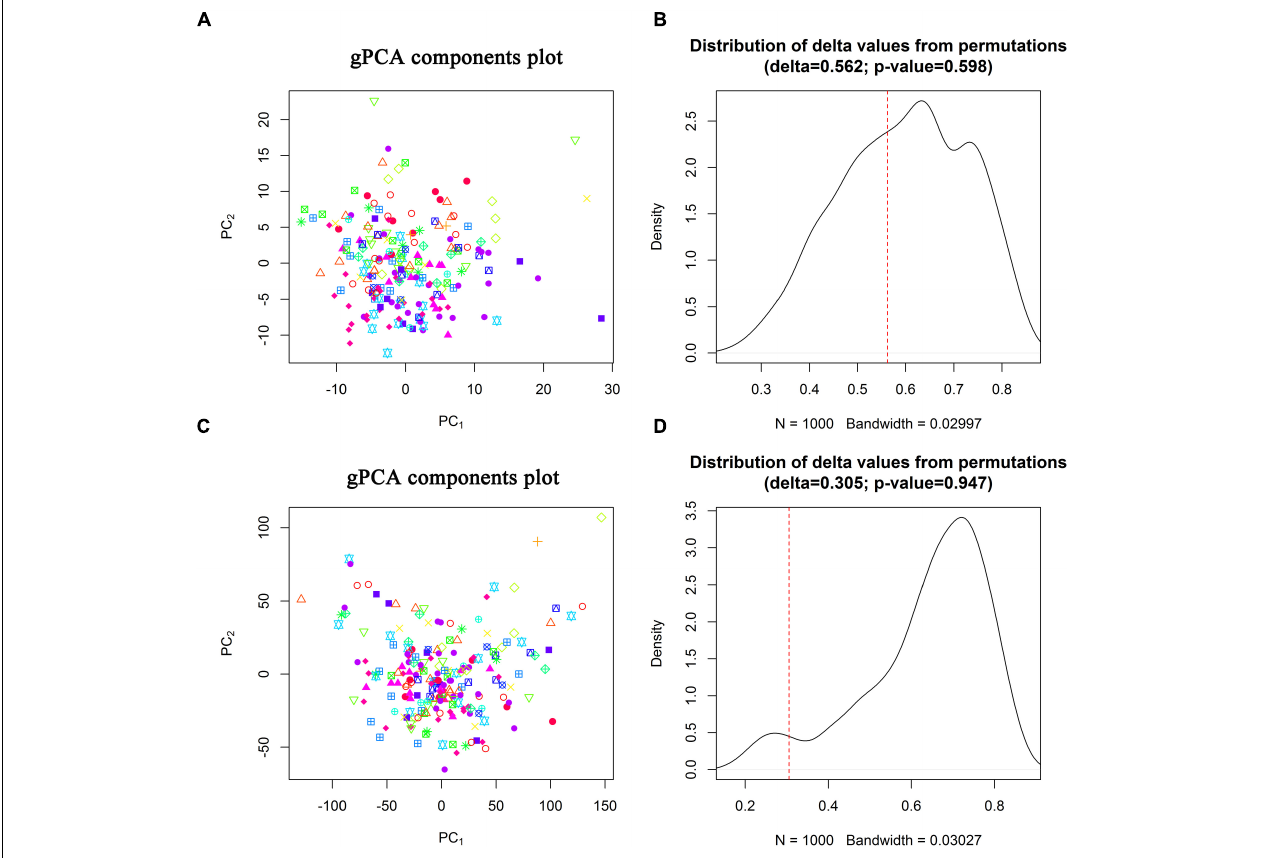
FIGURE 1 | Batch effect evaluation. Scatter plots of the first two guided principal components (A,C) and permutation tests (B,D) for miRNA isofrom sequencing data and gene sequencing